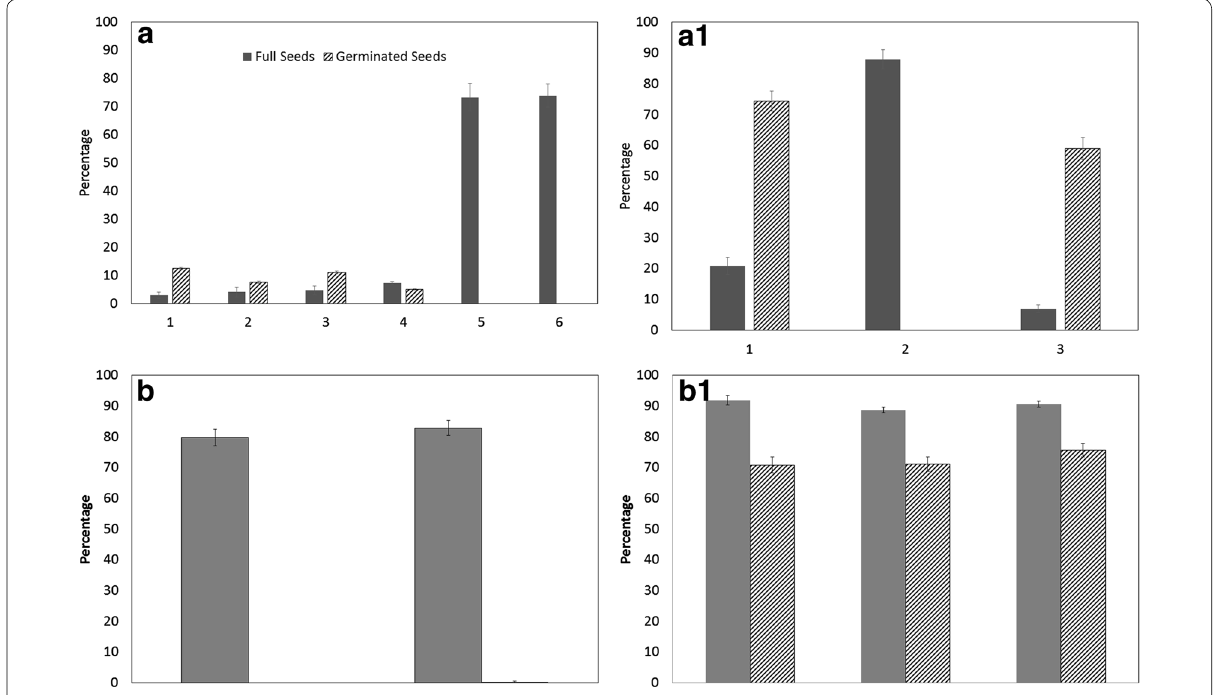
Fig. 7 Percent full seed and germination of Aerangis species after 6 months. a Aerangis ellisii mature capsule; a1 Aerangis ellisii in vitro collected capsule; b Aerangis sp. mature capsule; b1 Aerangis sp. in vitro collected capsule. Each numbered bar represents a single seed capsule. Mean of four replicates standard ±